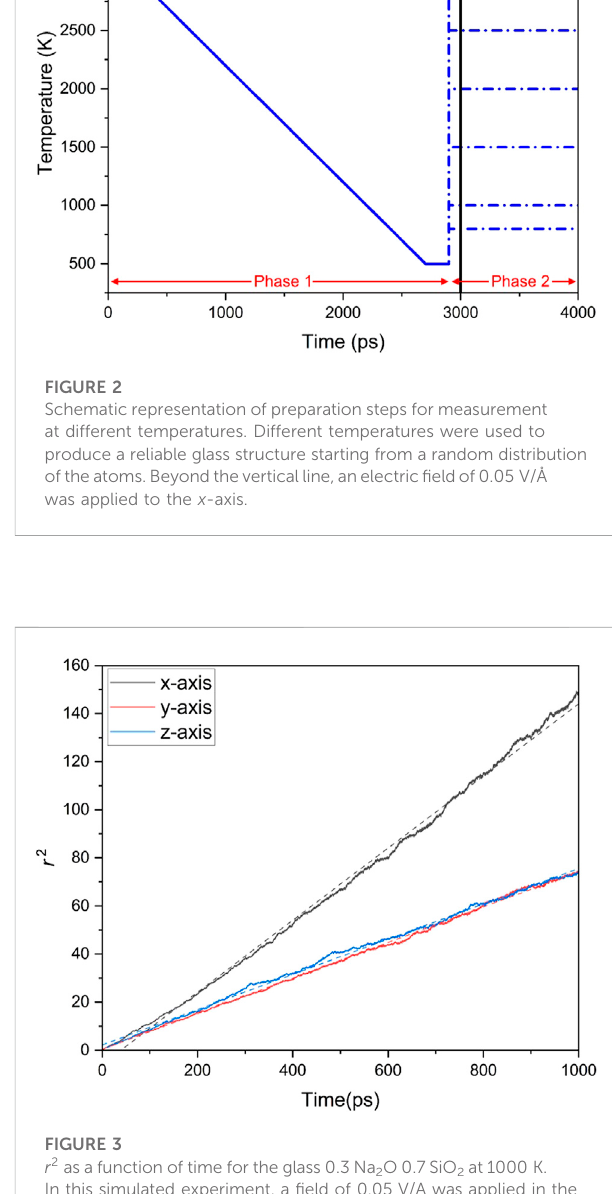
2 O 0.7 SiO 2 at 1000 K.